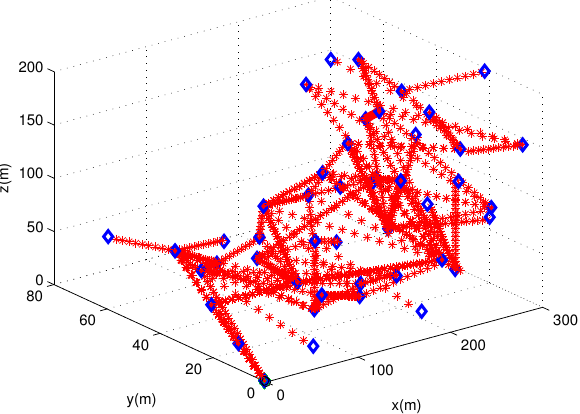
Figure 8. The path of each maneuvering AR until the user-specified complicated shape is entirely covered ( r sc = 50 m). The path of a maneuvering AR is depicted with red line segments. The final position of a maneuvering AR is depicted as a blue diamond. See that blue diamonds are marked at the end points of each line segment.